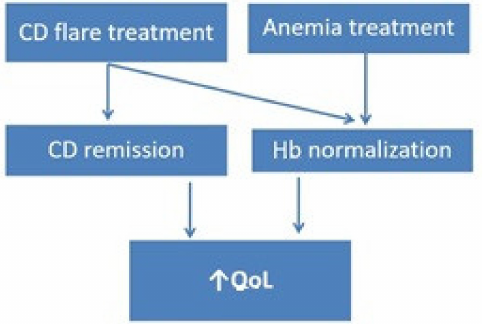
Figure 1. Practical management for improving quality of life in CD patients with anemia. CD: Crohn’s disease; Hb: hemoglobin; Qol: quality of